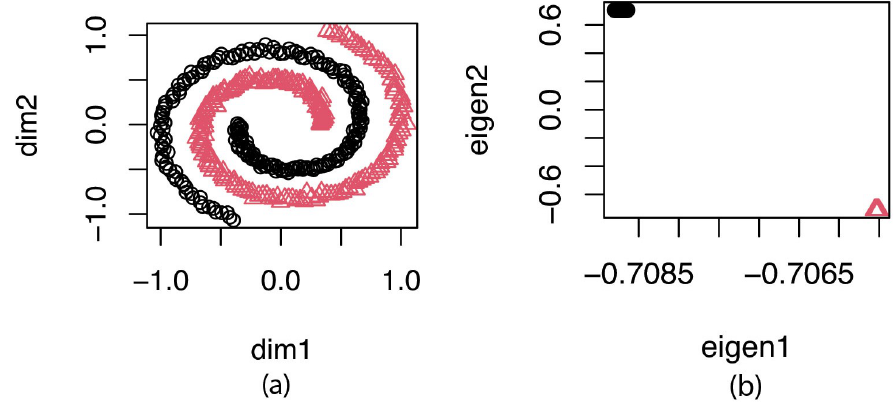
Figure 1. Simulated bivariate data set in the original space ( a ) and space obtained with the eigende- composition of L ( b ), colors and shapes represent the partition obtained with spectral